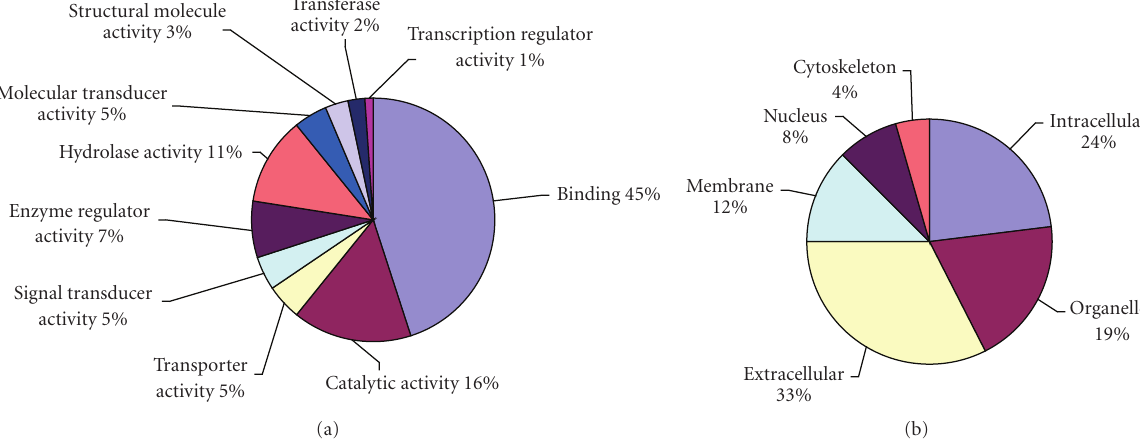
Figure 6: Pie charts showing the gene ontology classification of identified plasma proteins according to cellular function (a) and to cellular component category